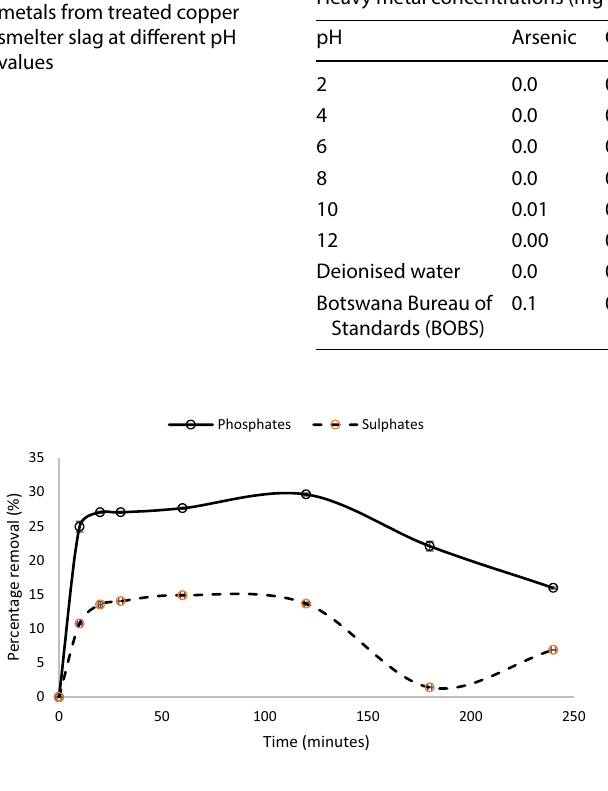
Fig. 3 Effect of contact time on phosphorus and sulphates adsorp- tion onto treated copper smelter